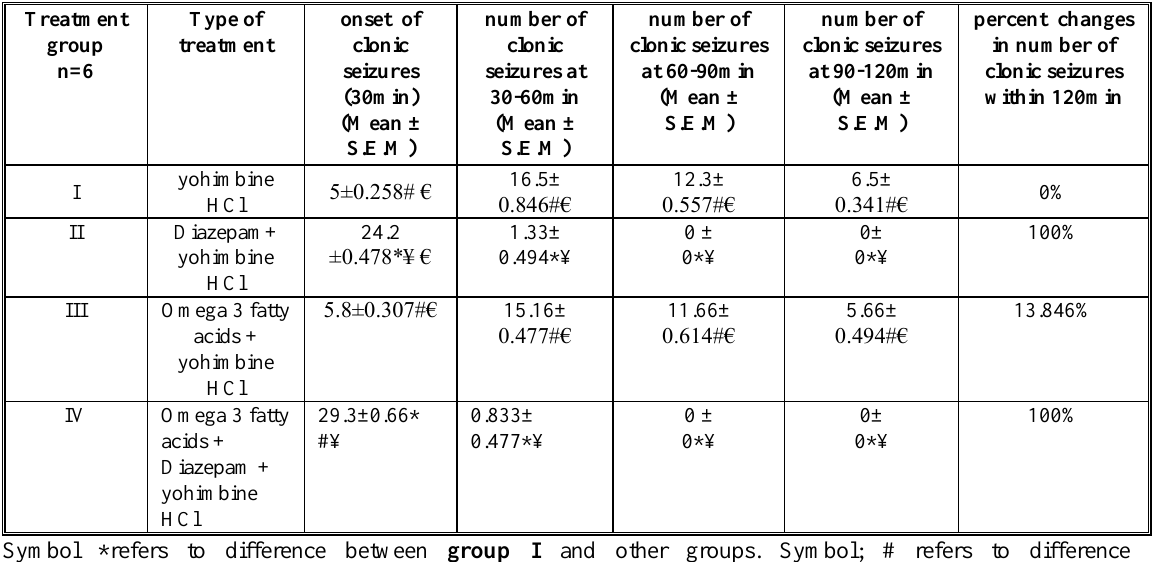
Table 1. Onset of clonic seizures during 30min,number of clonic seizure during different period from 30- 120min that induced by yohimbine and other treatment groups and percent changes in number of clonic seizures within 120 min